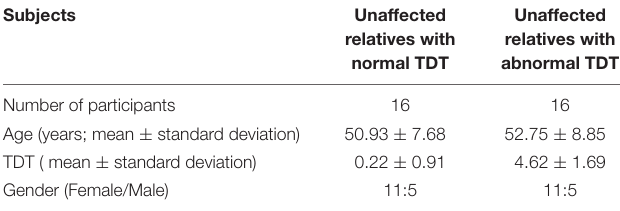
TABLE 1 | Participant